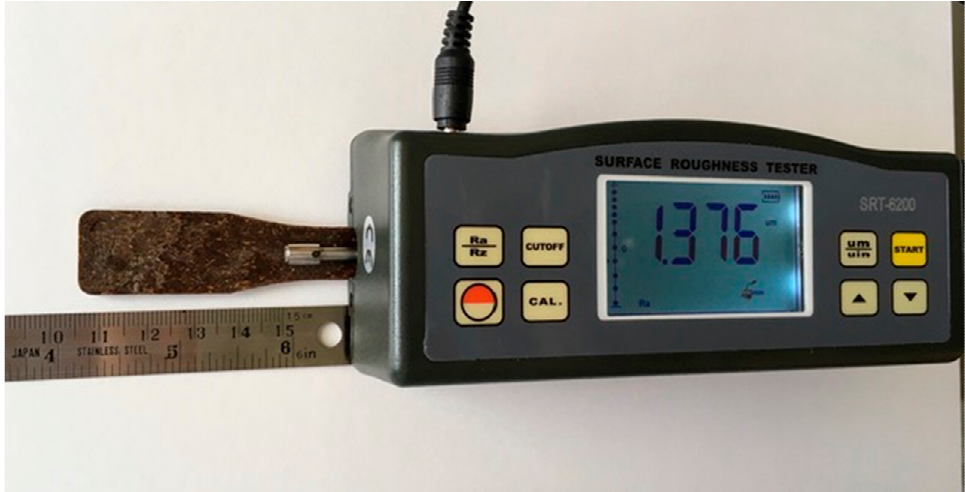
Figure 2. Stylus ‐ type profilometer. Figure 2. Stylus-type